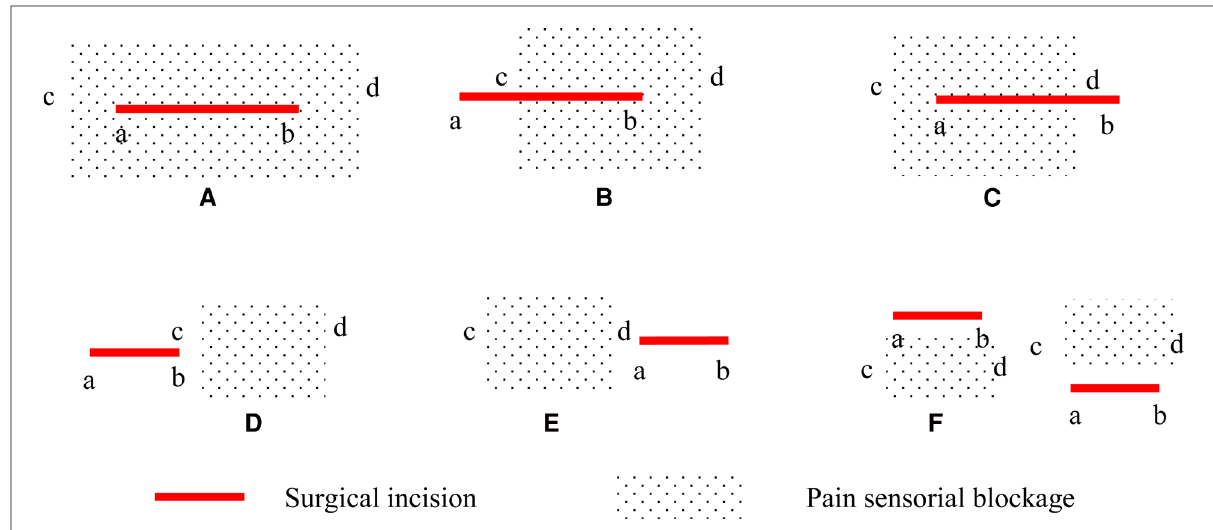
FIGURE 1 Surgical incision and pain sensorial blockage. ( A ) the coverage rate is de fi ned as complete blocking (100%); ( B ) the coverage rate is de fi ned as cb/ab * 100%; ( C ) the coverage rate is de fi ned as ad/ab * 100%; ( D ) or ( E ) the coverage rate is de fi ned as 0%; ( F ) or no hypoalgesia: blocking failure. a, the upper bound of the surgical incision; b, the lower bound of the surgical incision; c, the upper bound of pain sensorial blockage; d, the lower bound of pain sensorial